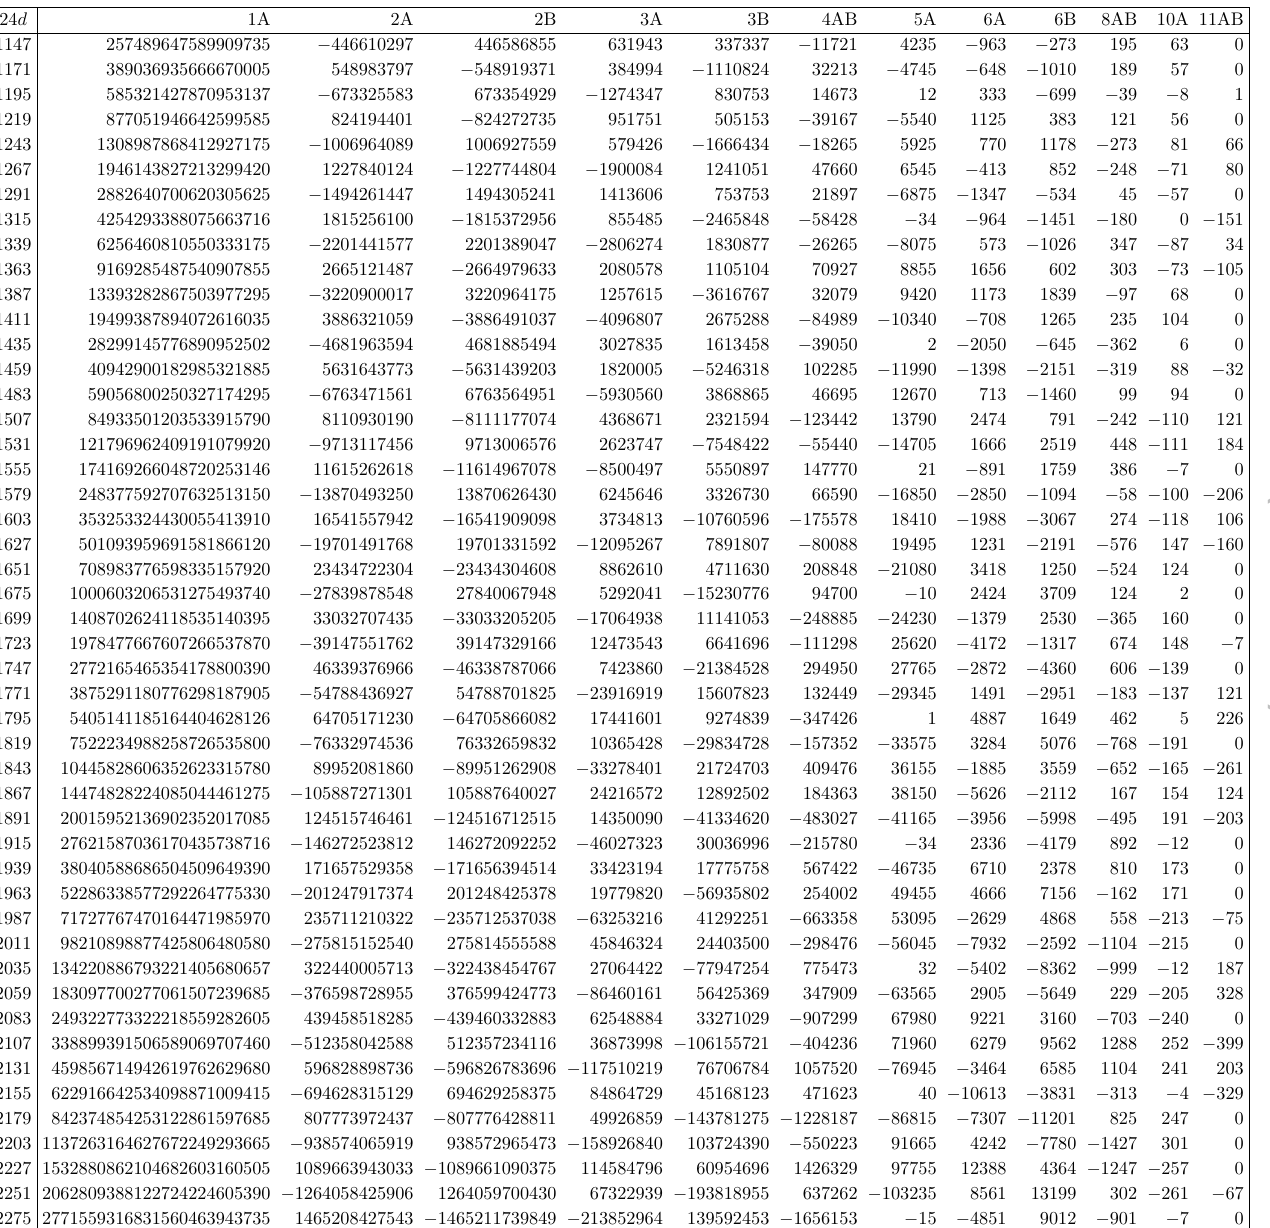
Table 3 . McKay-Thompson series f (1)